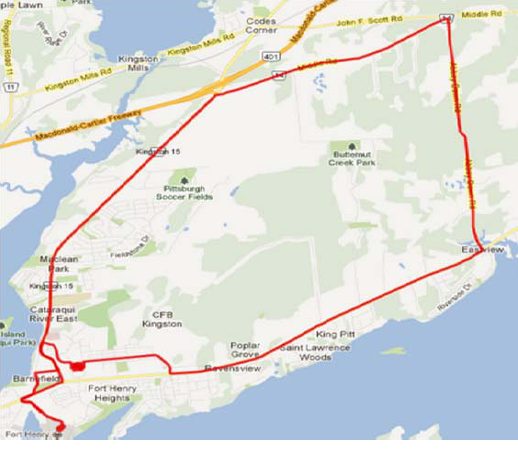
Figure 2. Trajectory